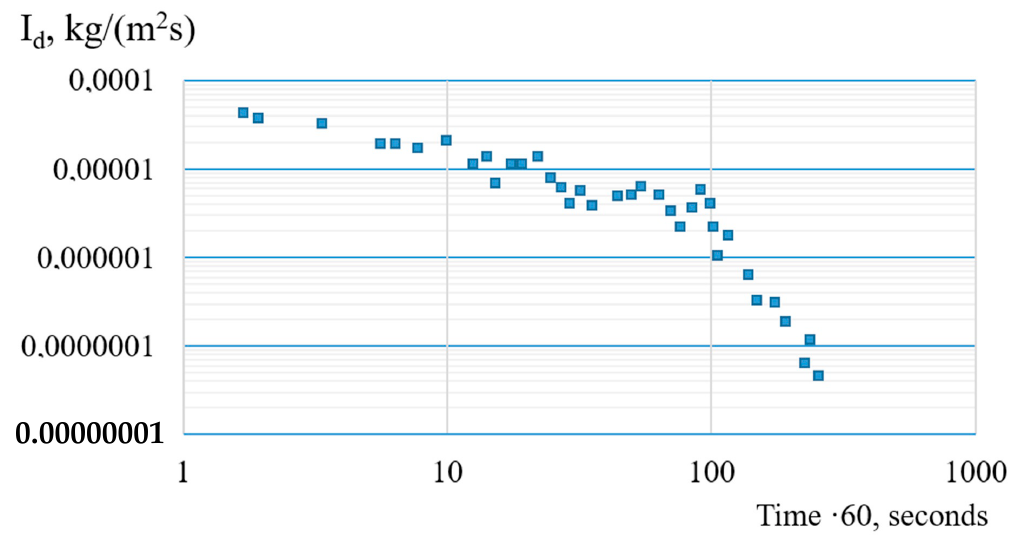
Figure2. Experimentaldataandapproximationofspecificmasstransferunderhydrateformationconditions. Energies 2020 , 13 , x FOR PEER REVIEW Figure 2. Experimental data and approximation of specific mass transfer under hydrate formation conditions.